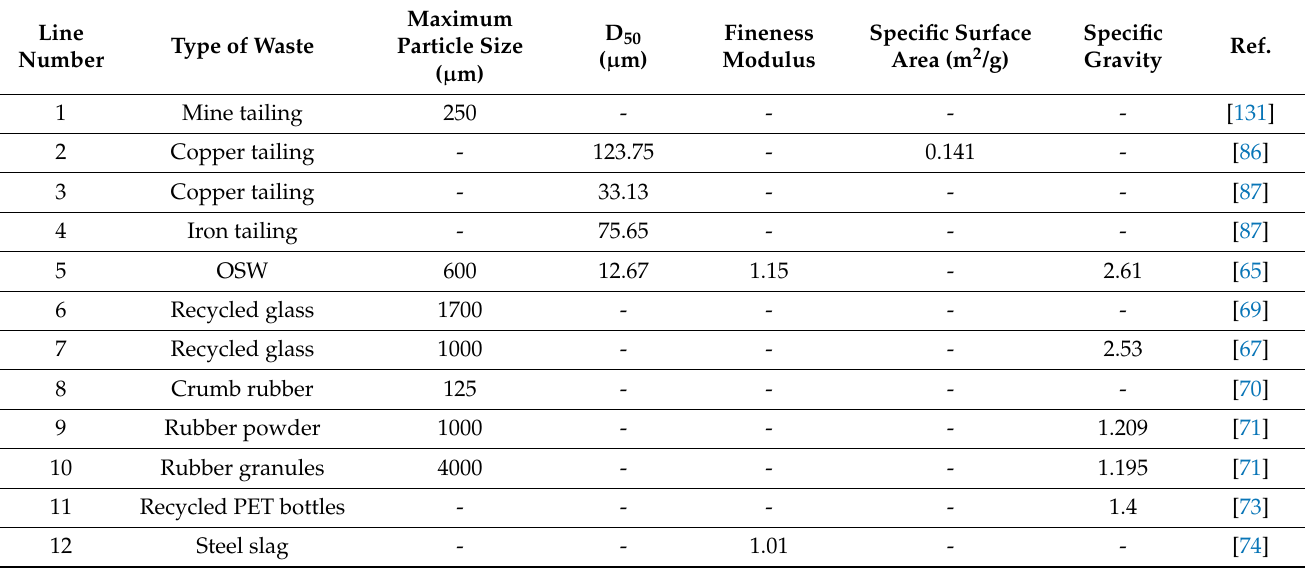
Table 7. Physical properties of different types of waste used as aggregate in 3DPCC mixtures, excluding recycled